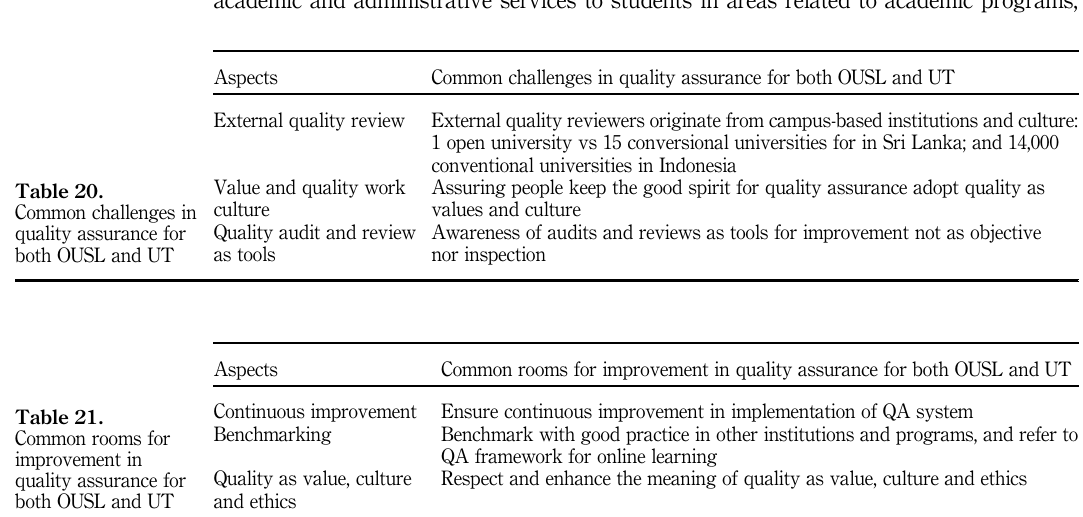
improvement in quality assurance